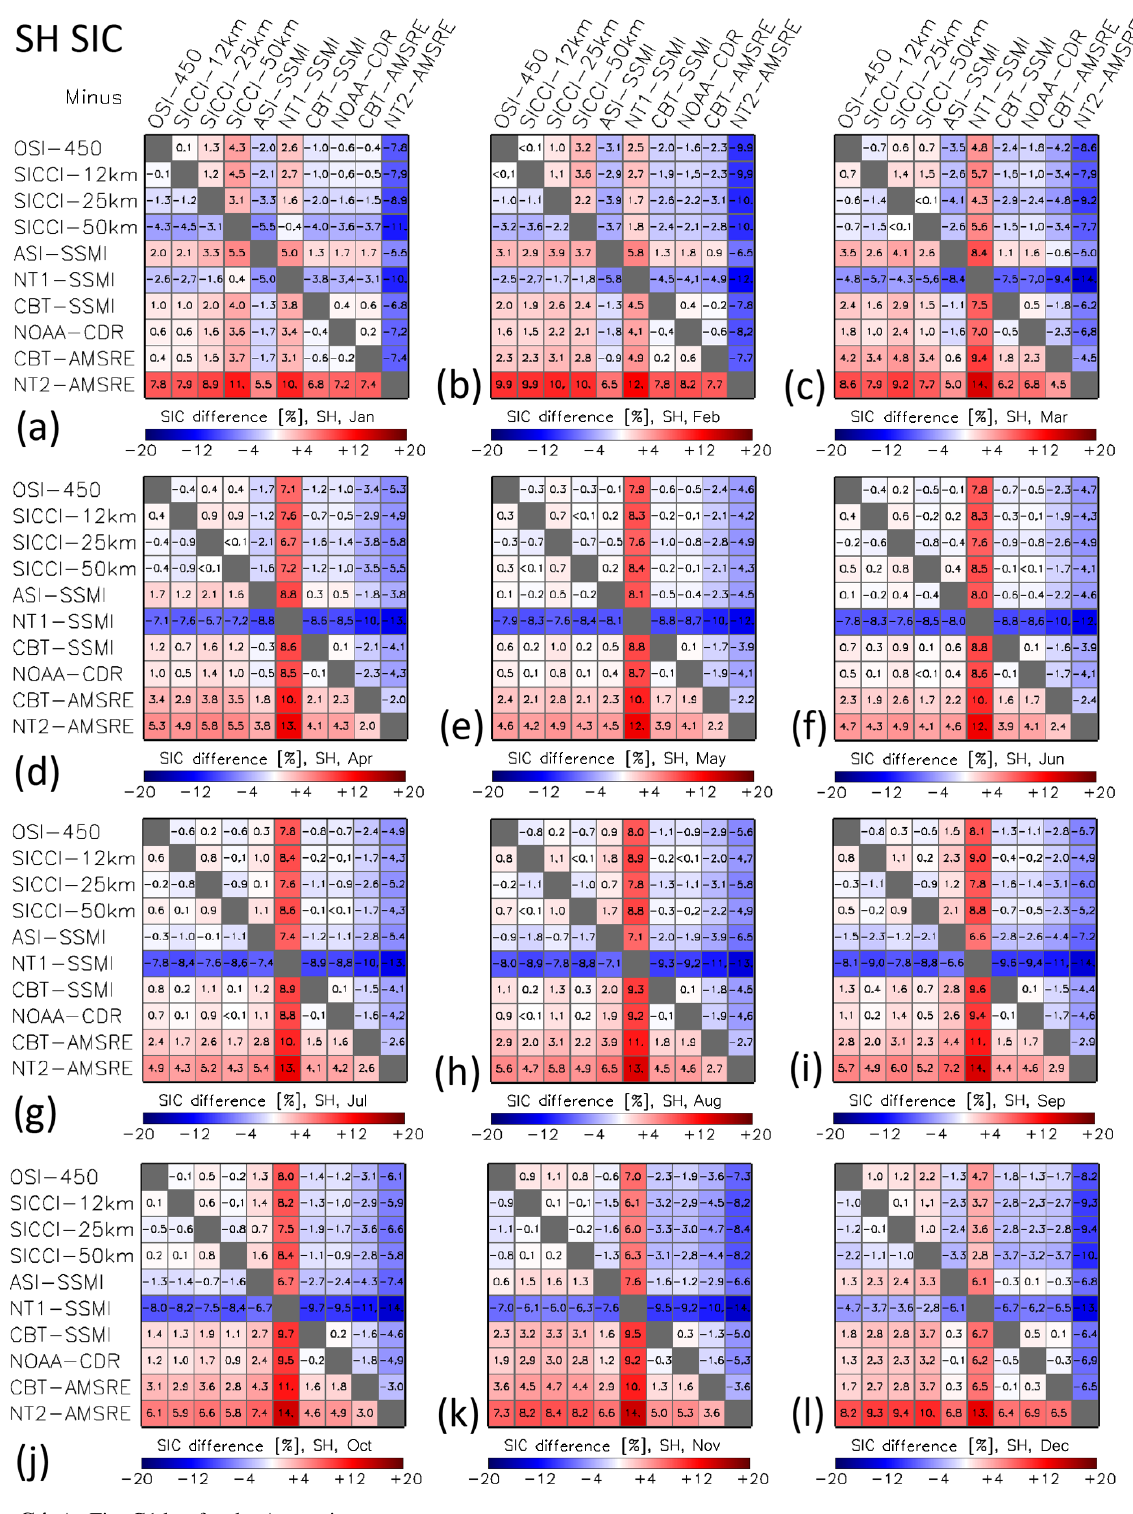
Figure G4. As Fig. G1 but for the